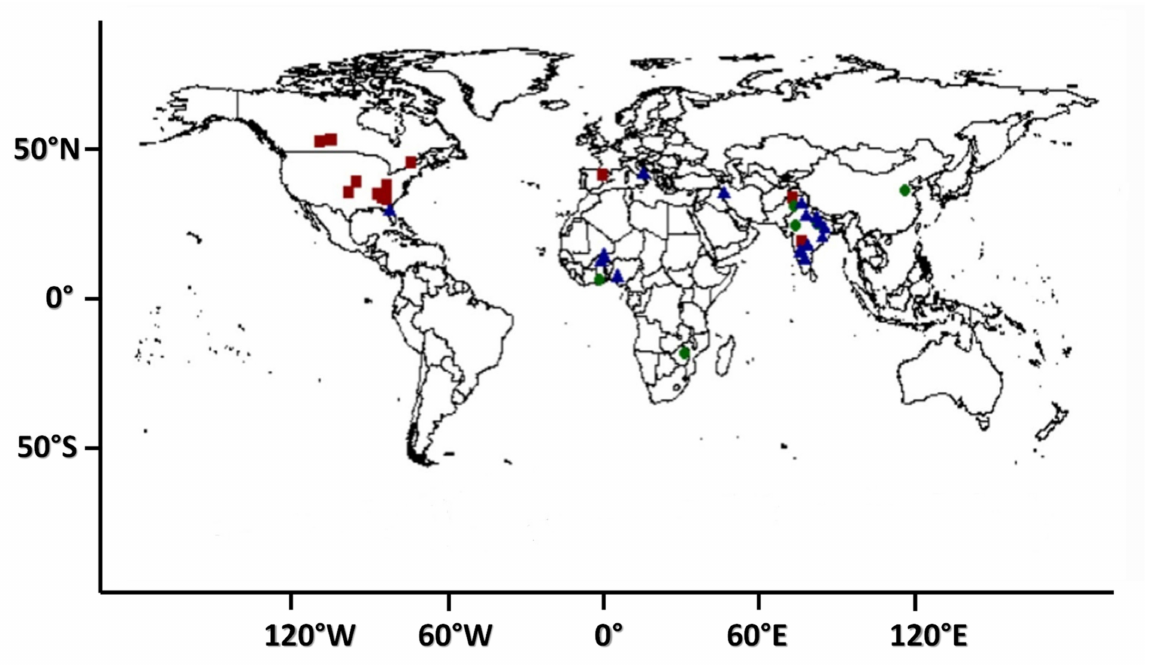
Figure 1. Locations of the studies included in the meta-analysis according to their longitude and latitude. Locations of studies evaluated only organic (O) versus inorganic (M) nutrient sources, were presented by [ (cid:4) ], and studies evaluated only combined organic and inorganic (MO) versus inorganic (M) nutrient sources were presented by [ • ], and finally studies evaluated both O and MO versus M were presented by [ (cid:78)